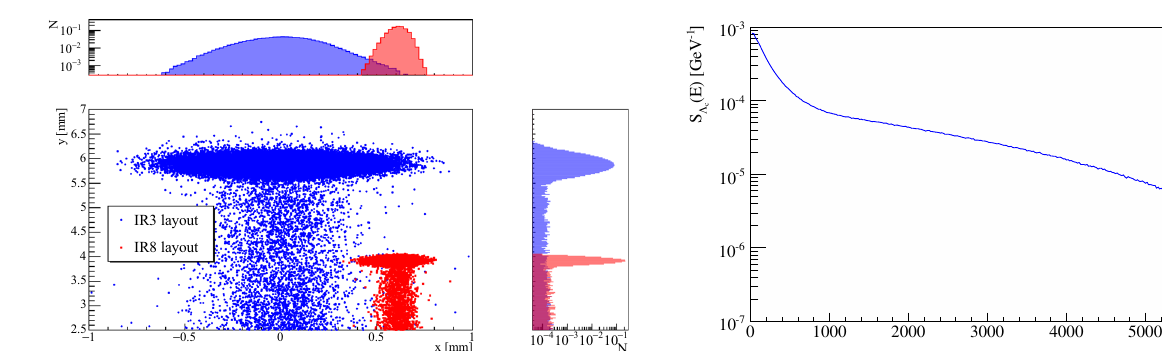
Fig. 12 Spectrum of (cid:2) c produced by 6.5 TeV/c protons on